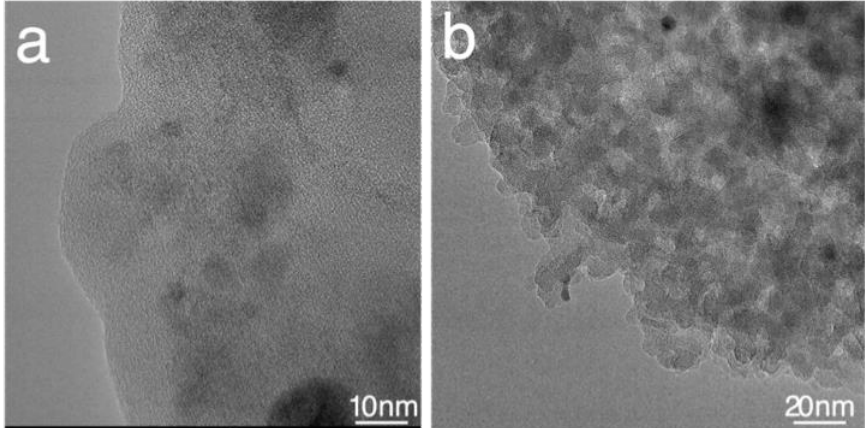
Figure 3. TEM image of MPR110-EW-P3 with ( a ) 10nm and ( b ) 20nm scale bar.